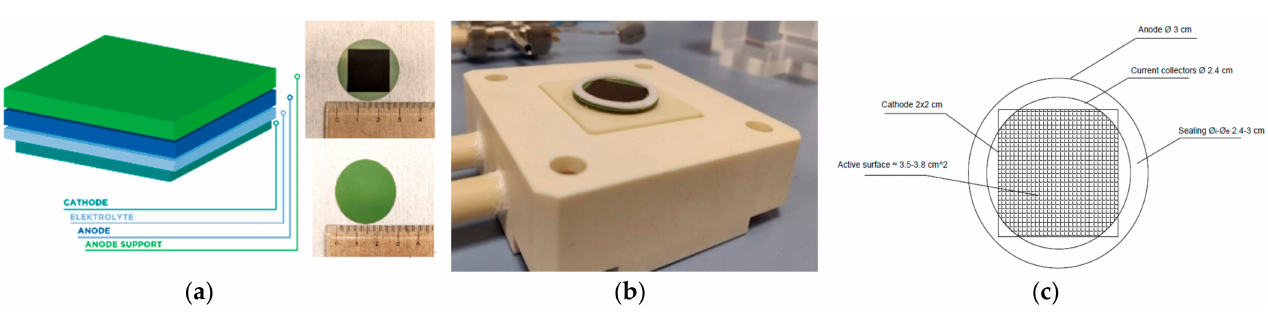
Figure 5. ( a ) Schematic and geometry of anode-supported SOFC (Ni-YSZ/YSZ/GDC-LSCF) (Ni-Yttria-Stabilized Zirco- nia/Yttria Stabilized Zirconia/Gadolinia Doped Ceria-Lanthanum Strontium Cobalt Ferrite) used; ( b ) button cell assembly in the holder; ( c ) Schematic of net active surface